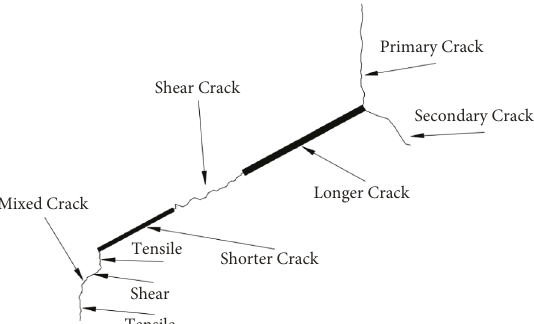
Figure 10: Schematic diagram of crack types and coalescence